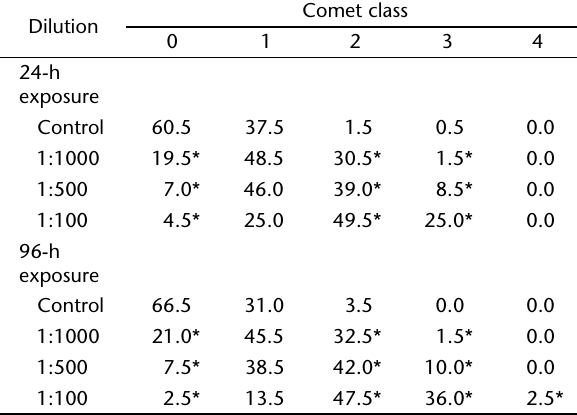
* Indicates a significant difference in comparison to control as indicated by the Kruskal-Wallis ANOVA and the Dunnett's test (p < 0.05).